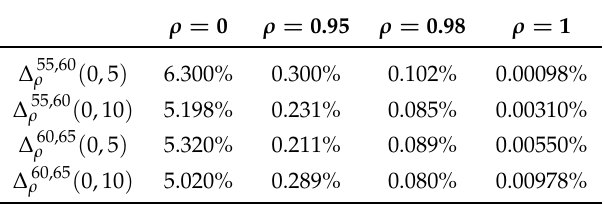
Table 9. ∆ y , z ρ ( 0, T ) values for different ages and maturities, COC approach. ρ = 0 ρ = 0.95 ρ =